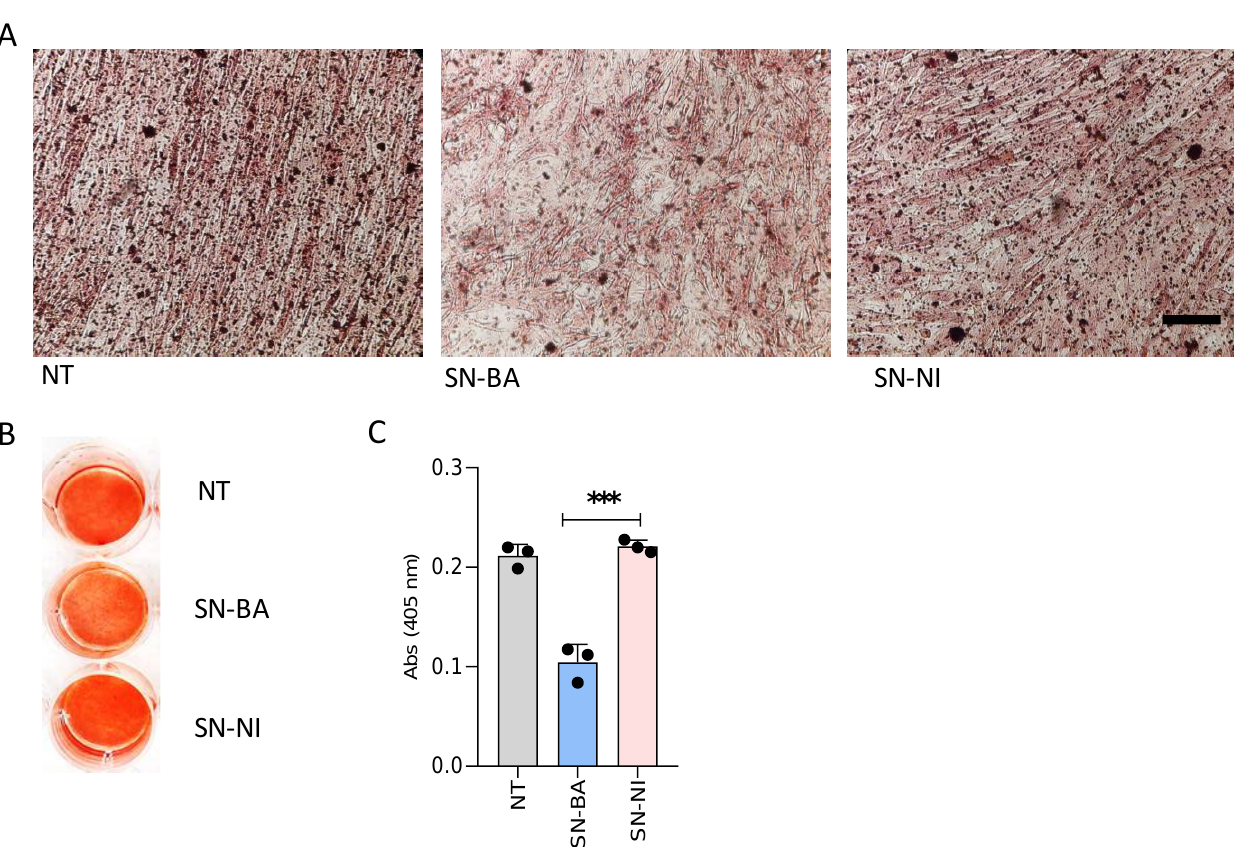
Figure 3. B. abortus -infected adipocytes inhibit mineral matrix deposition by osteoblasts. Effects of culture supernatants from B. abortus -infected adipocytes (SN-BA) on mineral deposition by osteoblasts. Culture supernatants from non-infected adipocytes (SN-NI) were used as control ( A , B ). Calcium deposition was revealed by spectrophotometric quantification ( C ). NT: non-treated. Scale bar: 50 µm. *** p < 0.0001 vs. cells treated with culture supernatants from non-infected adipocytes (SN-NI).